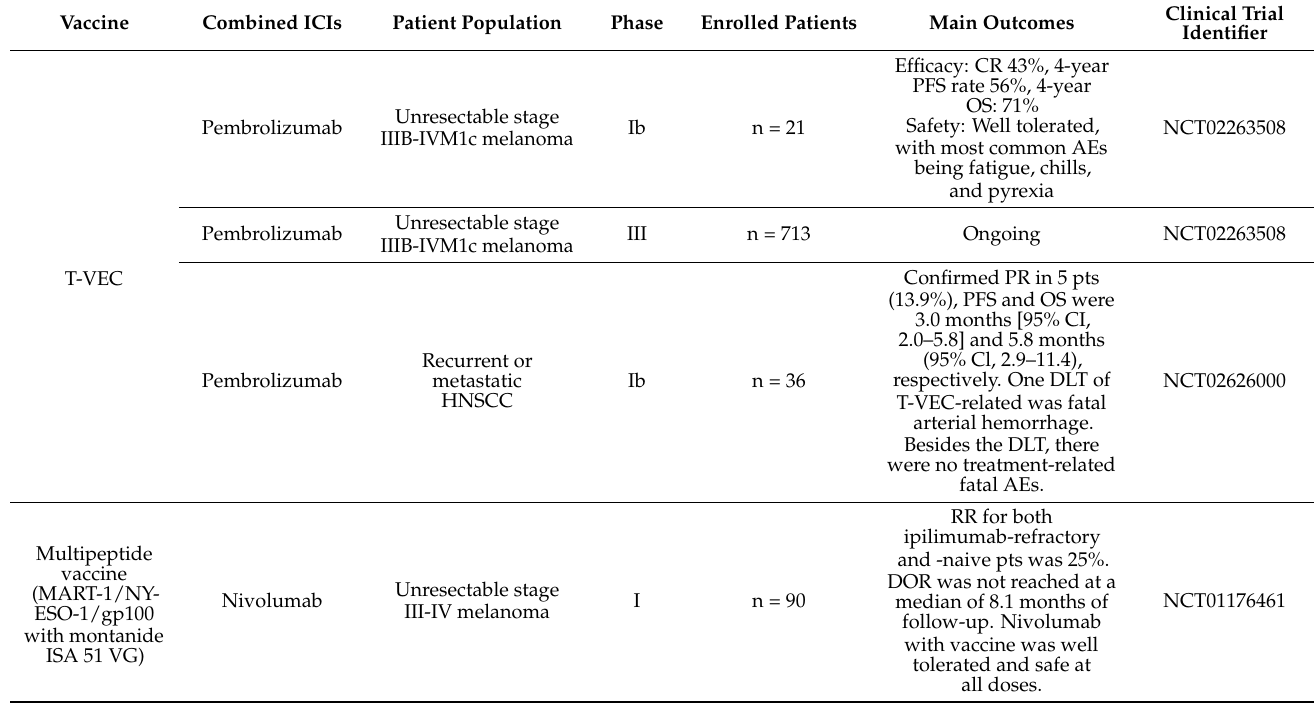
Table 2. Clinical evidence for combining vaccines and